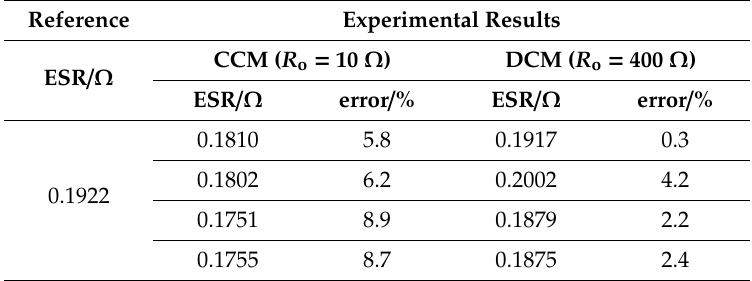
Table 6. ESR Experimental Results of Buck Converter by Method 2 before